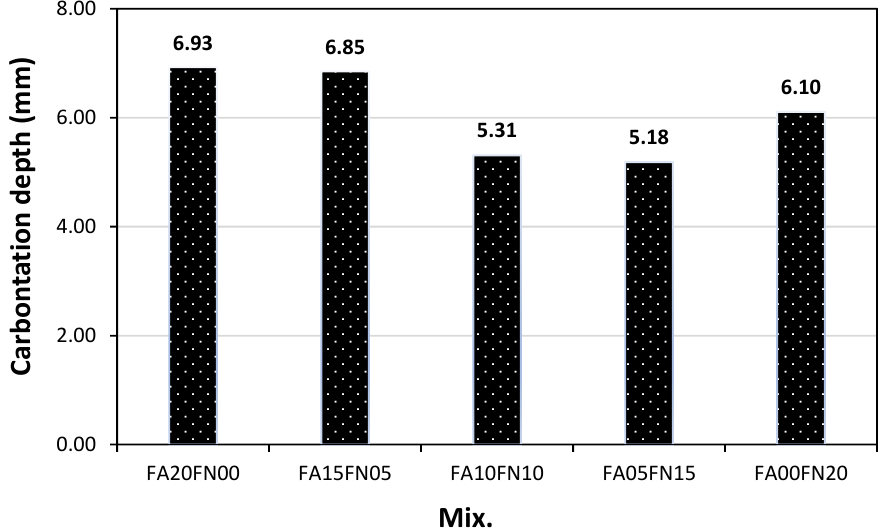
Figure 7. Accelerated carbonation depth.